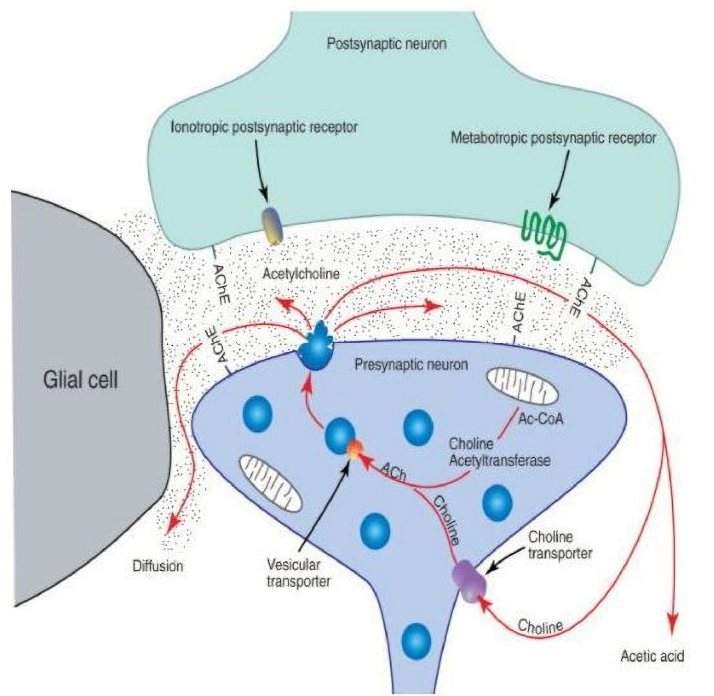
Figure 6. Synthesis of ACh by choline acetyltransferase at the presynaptic terminal.